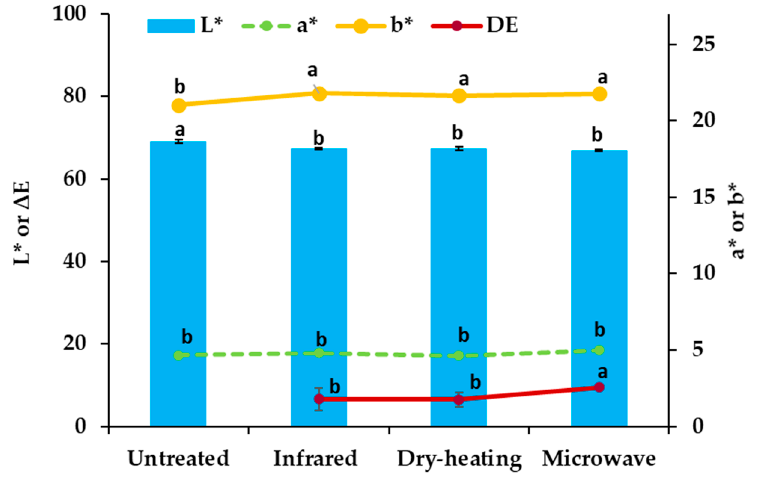
Figure 2. Effect of three different heating treatments (infrared-radiation, dry-heating, and micro- wave-heating) on color values of RB samples; values on bars or lines with specified by different letter are significantly different from each other ( p < 0.05).